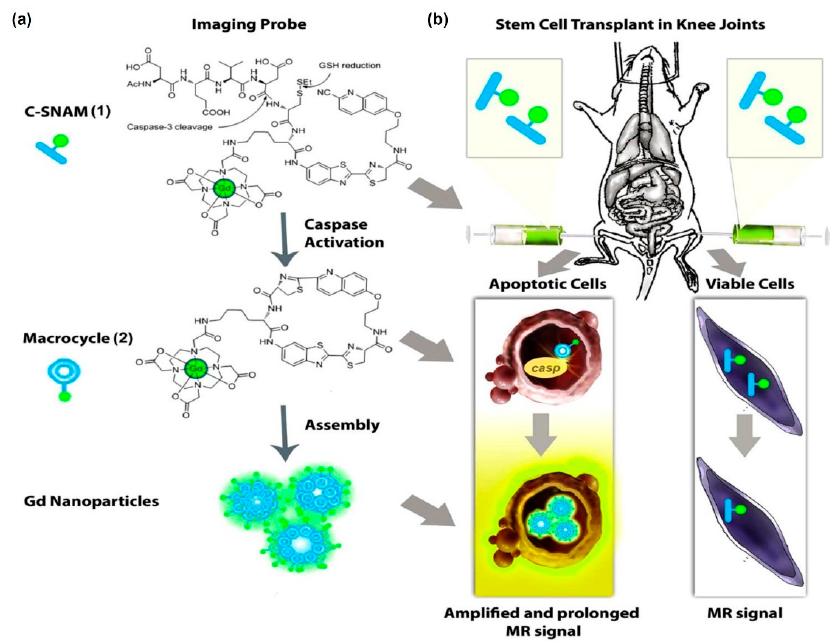
Figure 5. General design and mechanism of action of the caspase-3-sensitive nanoaggregation MRI probe (C-SNAM). ( a ) Chemical structure of C-SNAM. Following disulfide reduction and caspase-3-triggered DEVD peptide cleavage, C-SNAM transforms to a rigid and hydrophobic macrocyclic product 2, through a biocompatible intramolecular cyclization reaction between 2-cyano-6-hydroxyquinoline and D -cysteine residue. The macrocycle 2 will subsequently self-assemble into Gd nanoparticles, leading to an increase in longitudinal relaxivity (r 1 ) relative to the unactivated probe 1; ( b ) Corresponding mechanism of action in vivo. (1) Intra-articular injection of C-SNAM into rat knee joints with implants of apoptotic and viable stem cells. (2) In vivo activation of C-SNAM in apoptotic stem cell transplants through caspase-3-mediated activation. (3) Increased relaxivity and retention effect of GdNPs lead to enhanced MRI signal of apoptotic stem cell transplants. The images and caption are reprinted with permission from Nejadnik et al. [152].